Question: Describe this figure in one sentence.
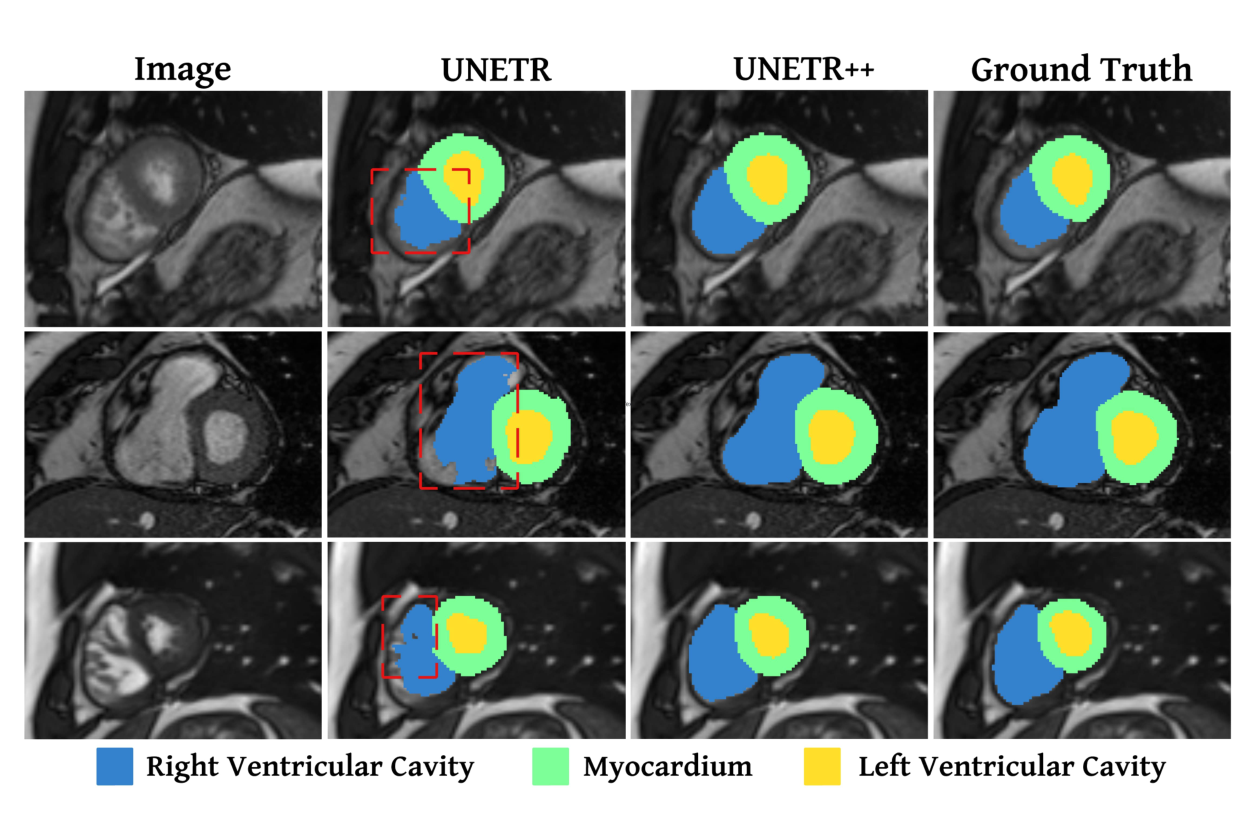
Answer: Additional qualitative comparison between UNETR++ and the baseline UNETR. The baseline struggle to correctly segment different heart regions (marked in red dashed box). We enlarge the regions from several cases. Our UNETR++ achieves promising segmentation performance by accurately segmenting all regions. Best viewed zoomed in.